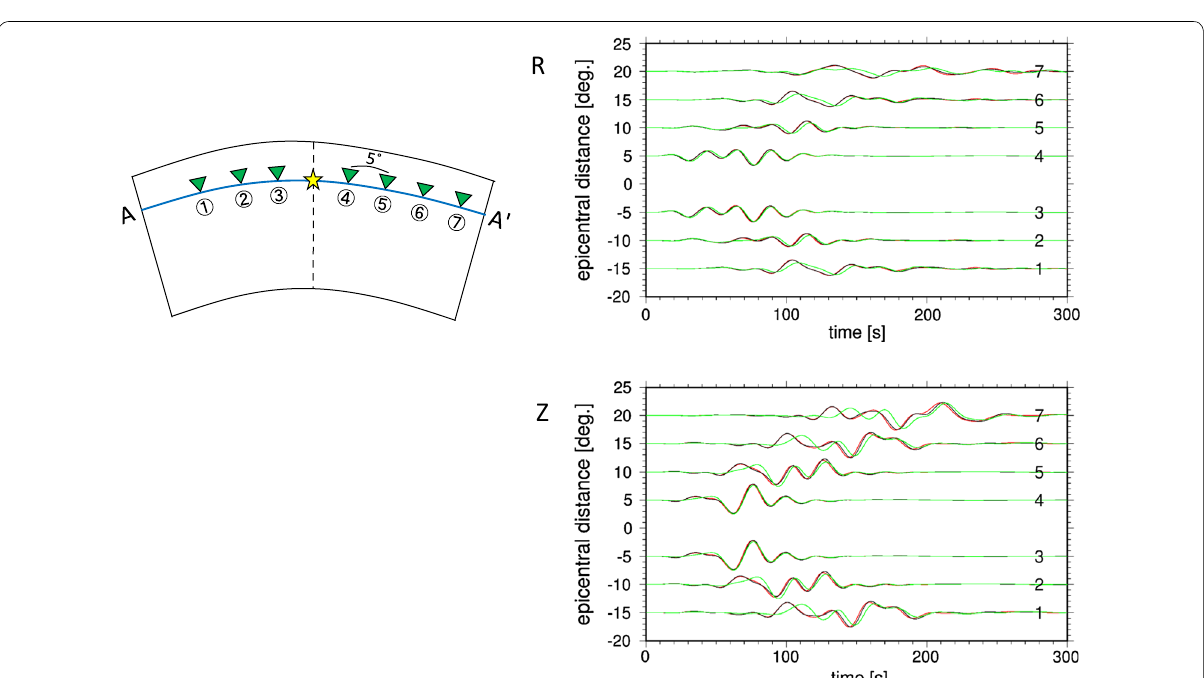
Fig. 6 Comparison among synthetic seismograms (particle velocity components) by three methods: quasi-Cartesian ( red line ), spherical ( black line ) and Cartesian ( green line ) FDTDs. Right upper and lower panels show the waveforms in the radial and vertical components, respectively. The ampli- tude of each trace has been multiplied by the epicentral distance. The number beside each trace indicates the receiver number corresponding to the location shown in the left